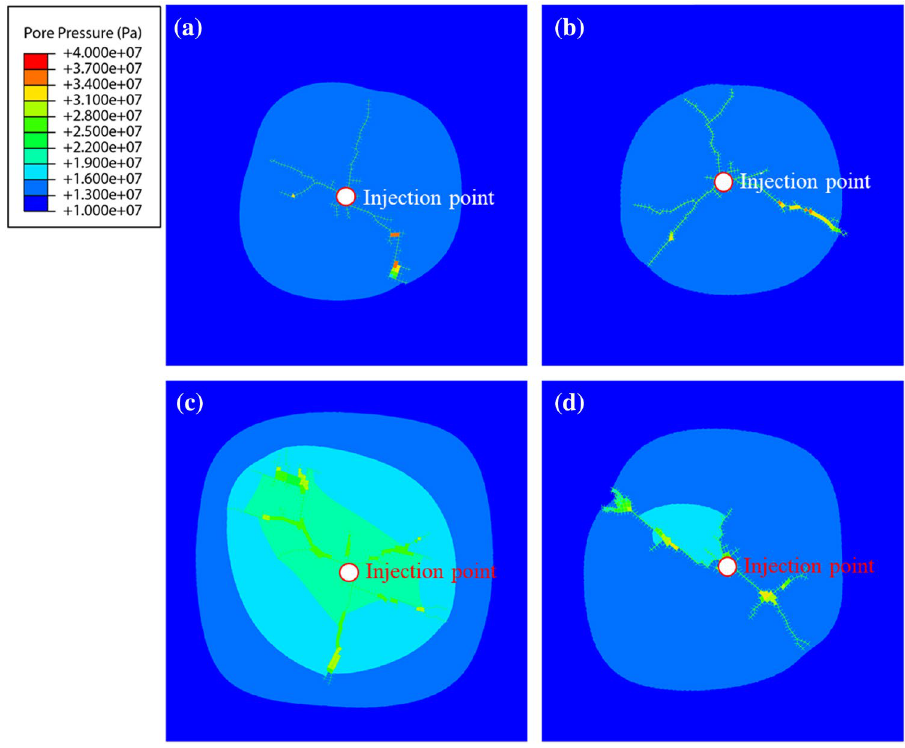
Fig. 5 Pore pressure distribution in formation at 30 min during fracturing. Each subfigure rep- resents a type of natural fracture group which randomly gener- ated previously. The positions of injection points are all near the midpoint of the